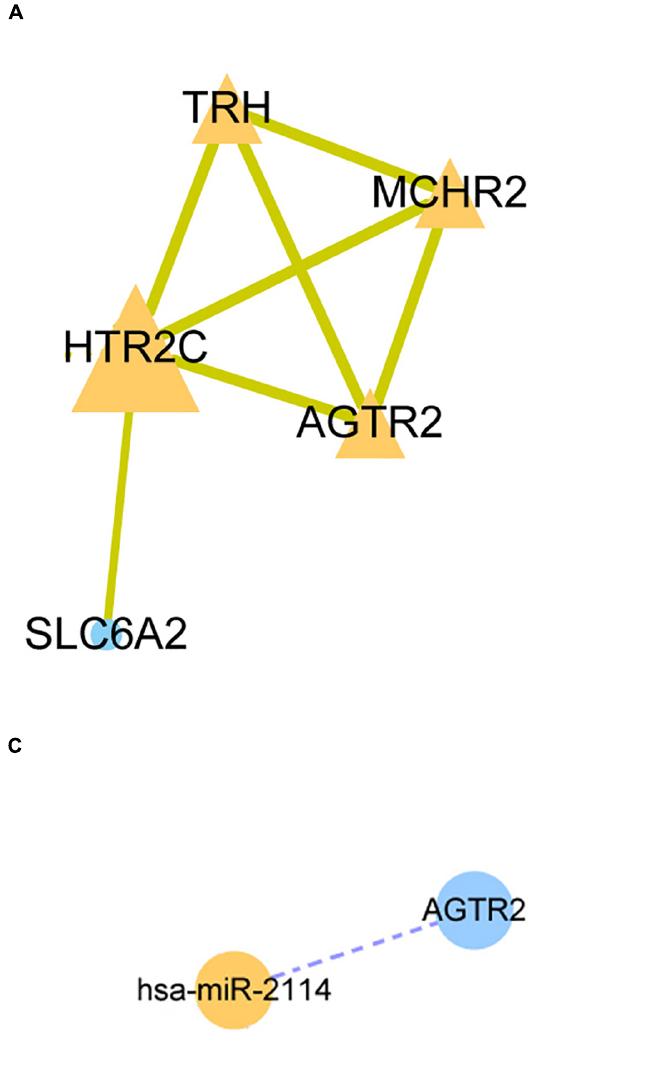
regulated by hsa-miR-2114 is one (AGTR2), the same with hsa- miR-466 (TRH) ( Figures 3C,D ). Based on these facts, the three miRNAs in the treatment of